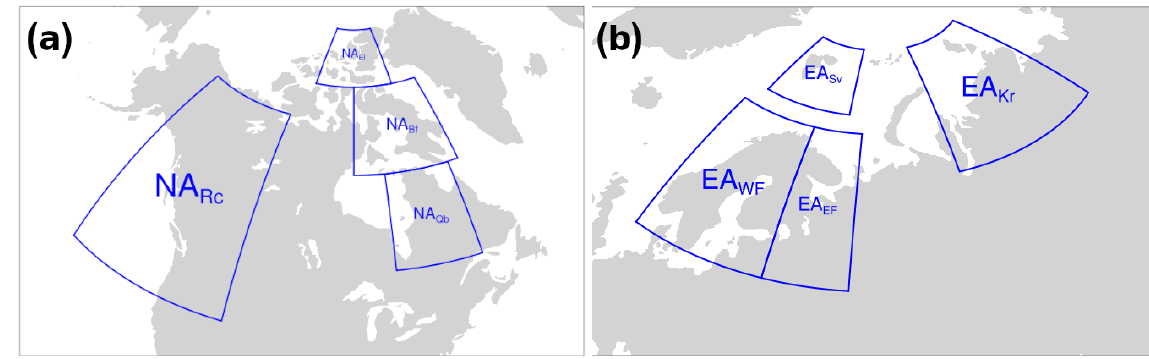
Figure 8. (a) NA sectors and (b) EA